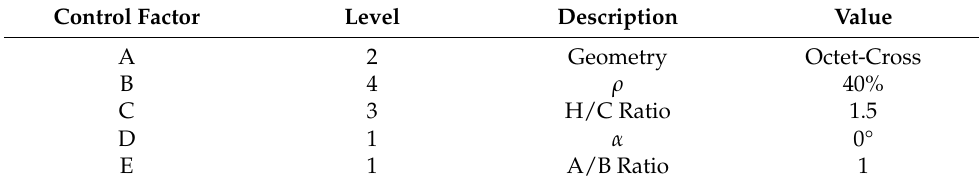
Table 7. Optimum Lattice Structure